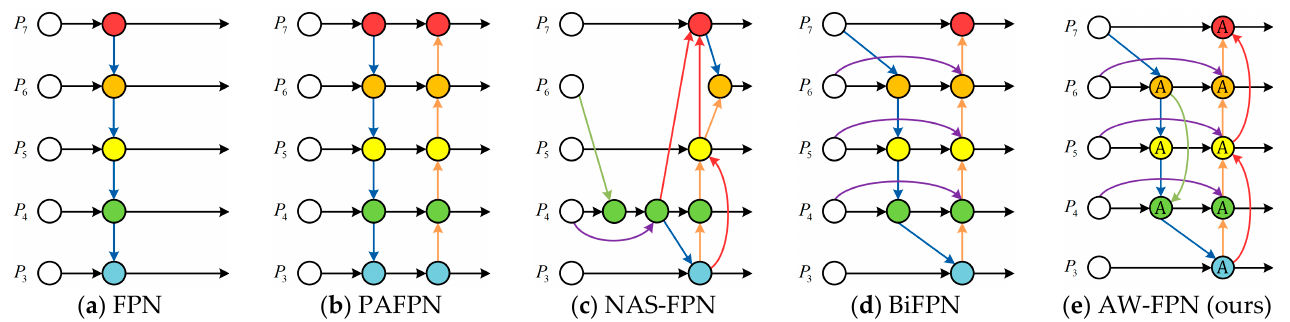
Figure 2. Feature fusion networks. Here, P i indicates the feature pyramid level i . ( a ) The FPN proposes a top-down pathway to fuse multi-scale features from P 3 to P 7 ; ( b ) PANet builds up an extra bottom-up pathway; ( c ) NAS-FPN designs the network topology by the neural architecture search; ( d ) BiFPN adds transverse skip-scale connections and learnable scalar fusion weights; ( e ) our AW-FPN with multiple skip-scale connections and attention-weighted feature fusion (AWF) mechanism.